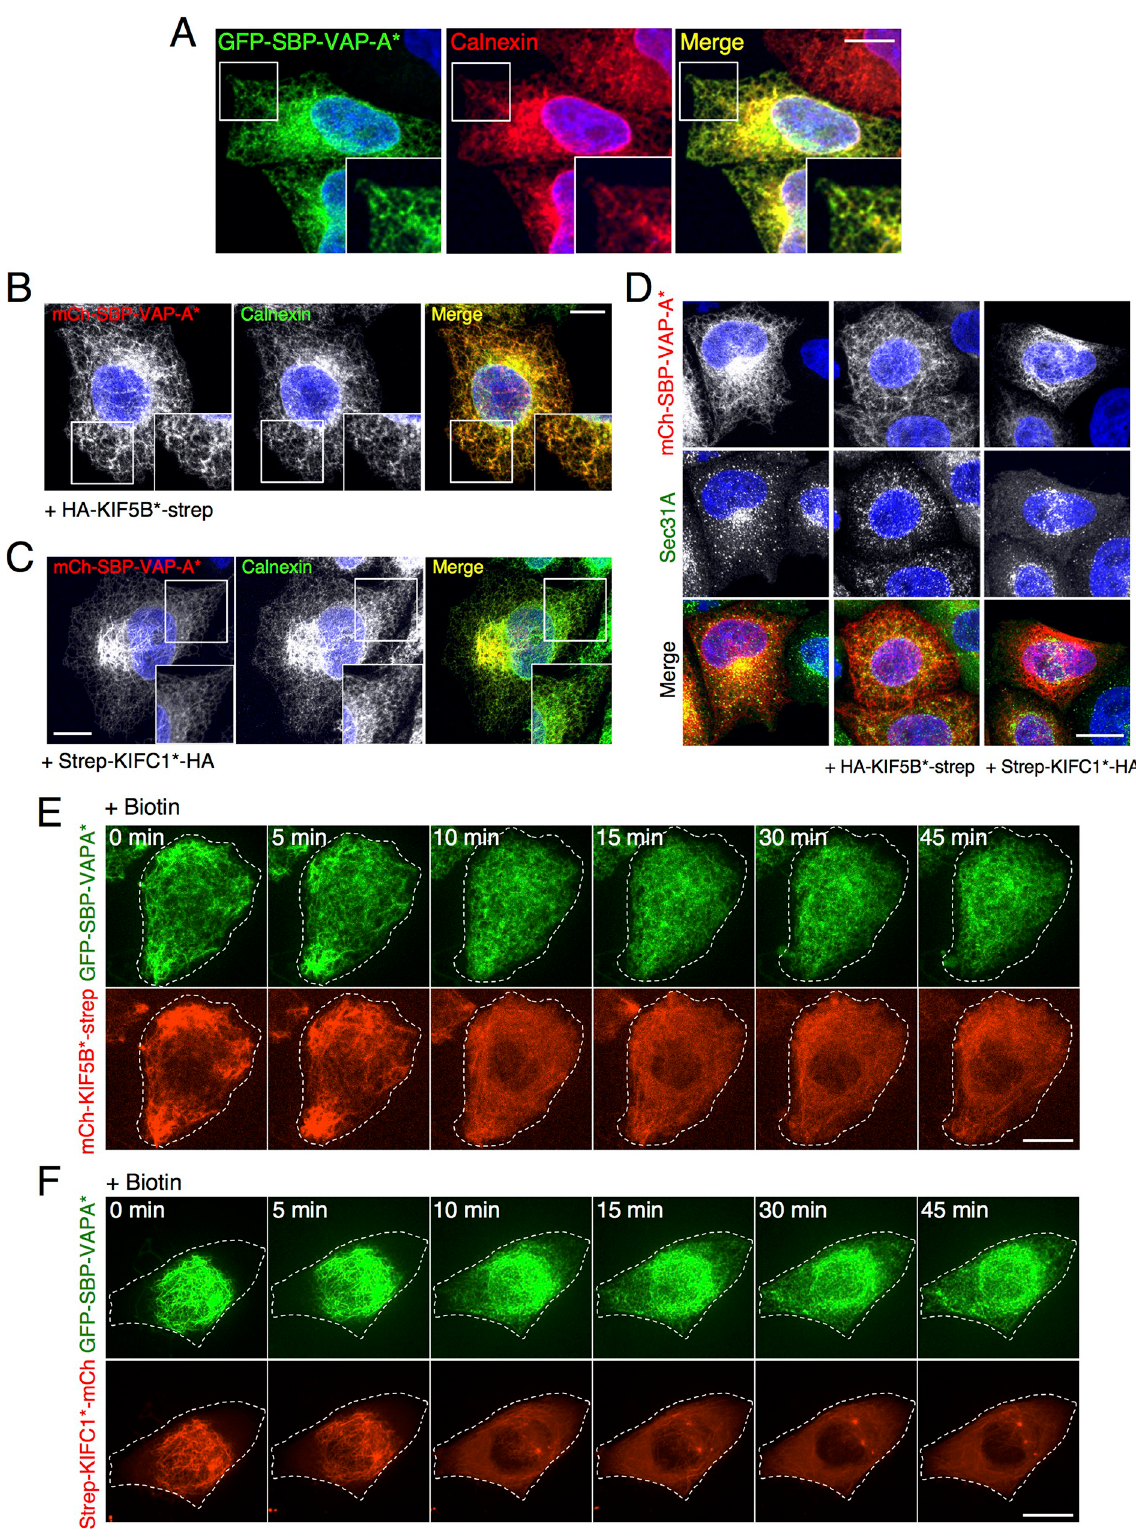
Fig 6. Redistribution of the ER with RAMP. (A) Confocal microscopy of HeLa cells expressing GFP-SBP-VAP-A � shows localization of the fusion protein to a network characteristic of the ER shown by costaining for endogenous calnexin, a luminal ER-resident protein. Insets